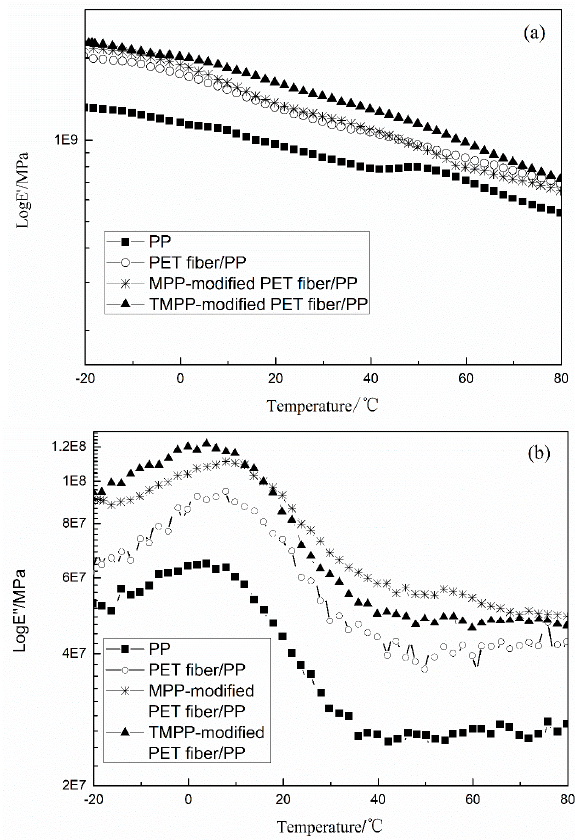
Figure 10. Dynamic properties of di ff erent PP composites ( a ): storage modulus, ( b ): loss modulus.